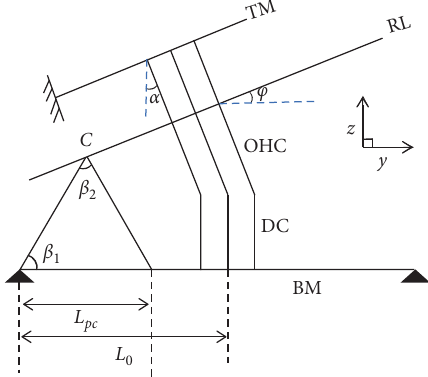
Figure 2: Micromechanical model of OC structure. L pc is the distance between the left end and the right end of the arch structure, L is the distance between the bottom of the middle row 0 of OHCs and the left end of the BM, ϕ is the acute angle between OHCs and z -axis, α is the acute angle between OHCs bundles and � β � β is the inside z -axis, α and ϕ have the same value, and β 1 2 angle of the arch